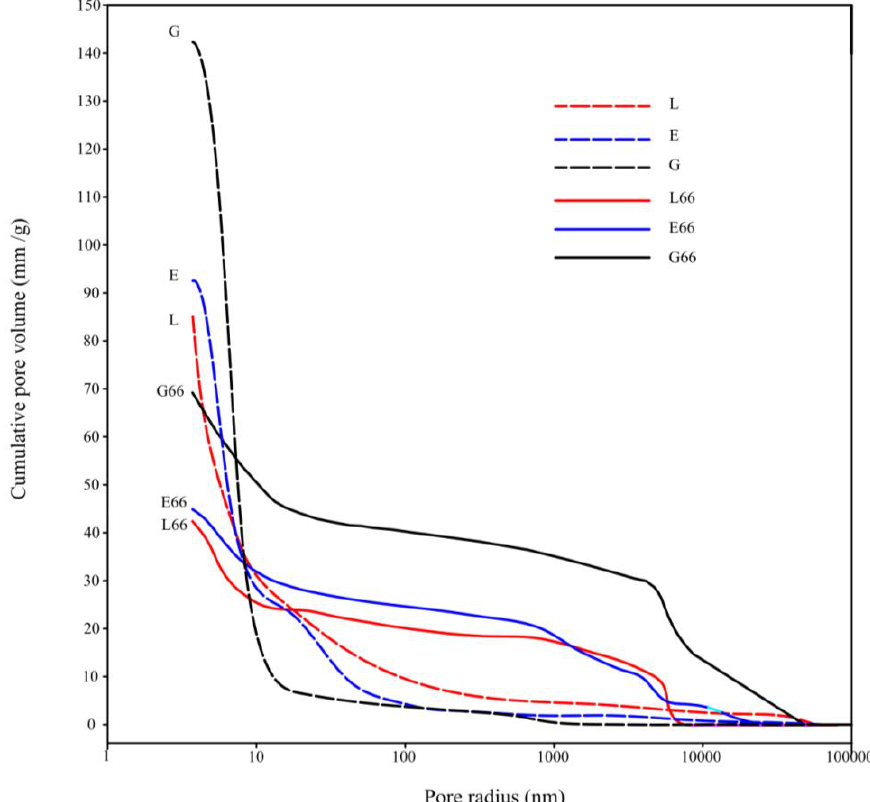
Figure 4. Cumulative pore volume vs. pore radius as obtained by mercury